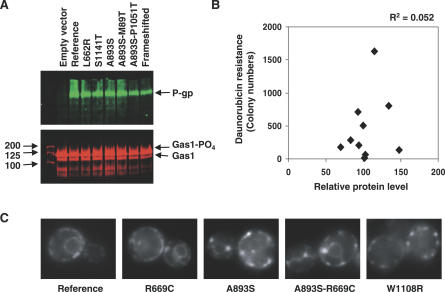
Protein Level and Subcellular Localization of P-Gp Variants(A) Immunoblot analysis for P-gp variants expressed in the plasma membrane fraction of yeast cells. Two-color immunoblot detection was used to quantify the level of P-gp variants compared with the level of yeast Gas1, a membrane protein-loading control. The positions of molecular standards (in kilodaltons) are indicated at the left. The arrows at the right indicate the position of the P-gp and Gas1 proteins expressed in yeast cells. All P-gp variants were expressed within a 1.5-fold range from the reference P-gp. The average ± standard deviation of three measurements of relative protein levels is 103 ± 19 for A893S, 83 ± 17 for S1141T, 94 ± 16 for A893S-R669C, 115 ± 20 for A893S-M89T, 93 ± 19 for L662R, 70 ± 22 for A893S-P1051A, 134 ± 25 for R669C, 102 ± 18 for W1108R, 148 ± 24 for R669C-W1108R, and 53 ± 13 for frame-shifted, relative to the average of reference P-gp set to 100. The cells expressing the frame-shifted P-gp produced the least amount. The truncated length of the frame-shifted protein was not recognized in this gel.(B) The relationship between daunorubicin resistance and P-Gp protein levels. The x-axis shows the relative protein level for each variant protein with the level for the reference set at 100. The y-axis shows daunorubicin resistance represented as colony numbers surviving on the high-concentration daunorubicin plates.(C) Subcellular localization of GFP-fused P-Gp variants. P-Gp variants were localized to the plasma membrane and the vacuolar membrane in yeast cells. The images were taken when the cells reached midexponential phase (OD600 = 0.7). The cells expressing each P-gp variant fluoresced to similar extents, regardless of the drug resistance phenotypes.